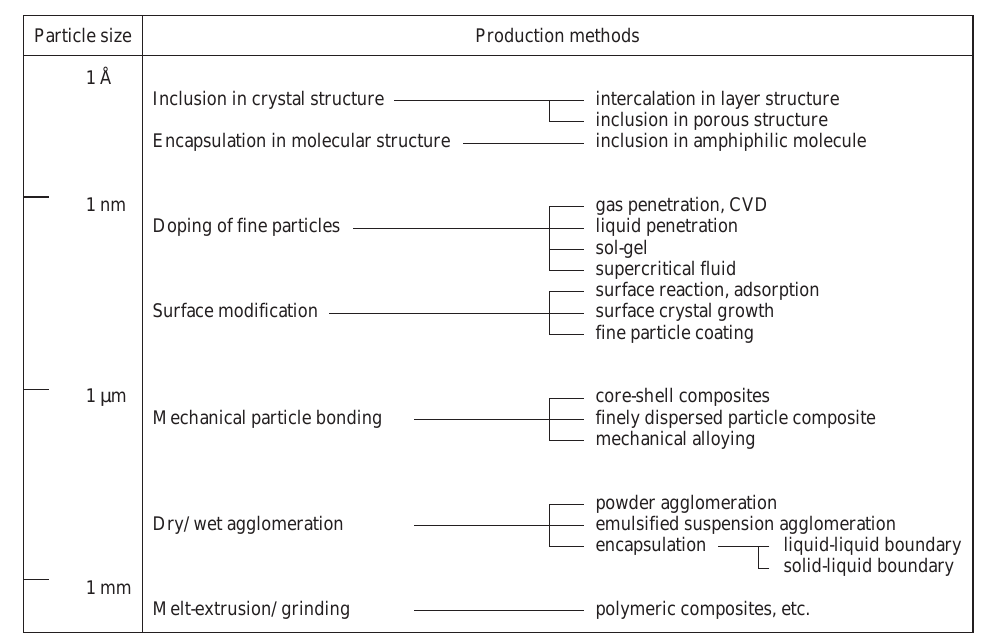
Methods to make composite particles